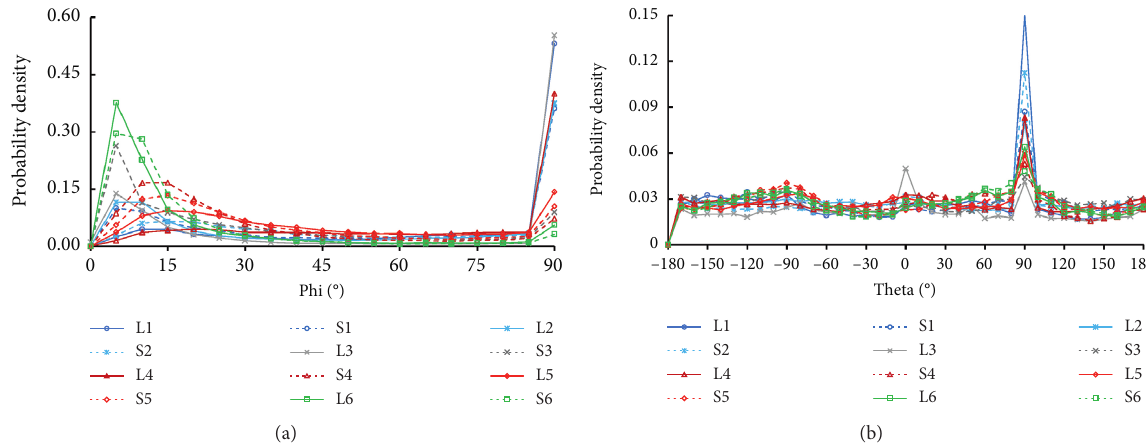
Figure 7: Orientation characteristics of loess particles: (a) phi; (b)